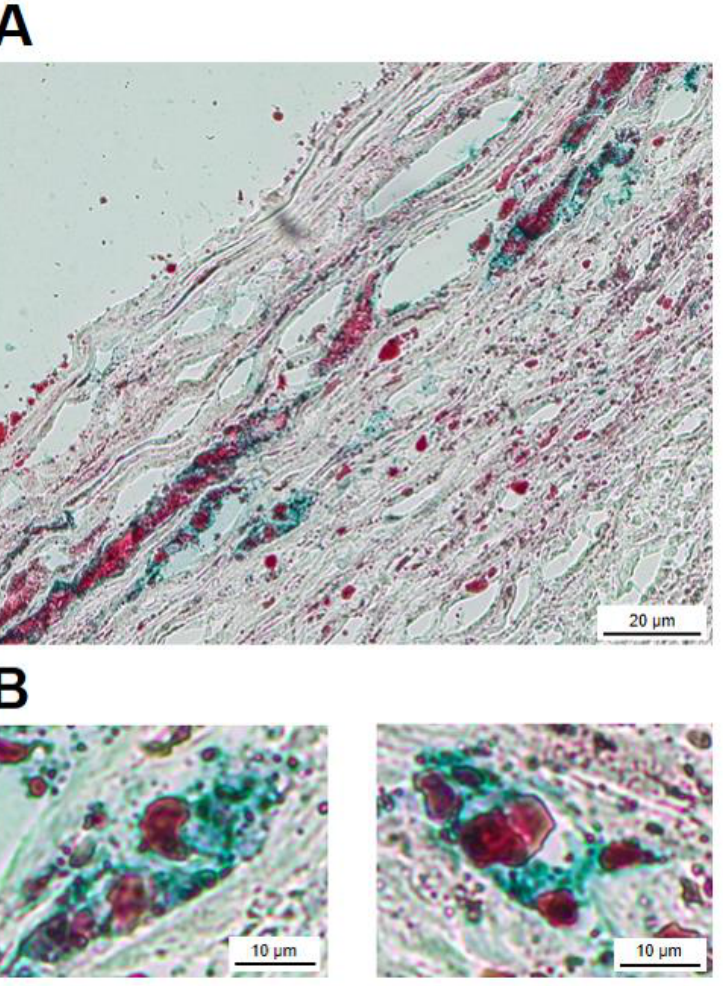
Figure 5. Atheromatous plaque cryosections with combined Oil Red O (ORO) and FXIII-A staining (PolyDetector HRP Green chromogen). ( A ) Numerous macrophages, some with foamy cytoplasm, in which the presence of ORO-positive vacuoles can be observed. ORO-positive droplets are also present in the extracellular compartment. ( B ) Examples of two FXIII-A-positive macrophages which were also stained with ORO.